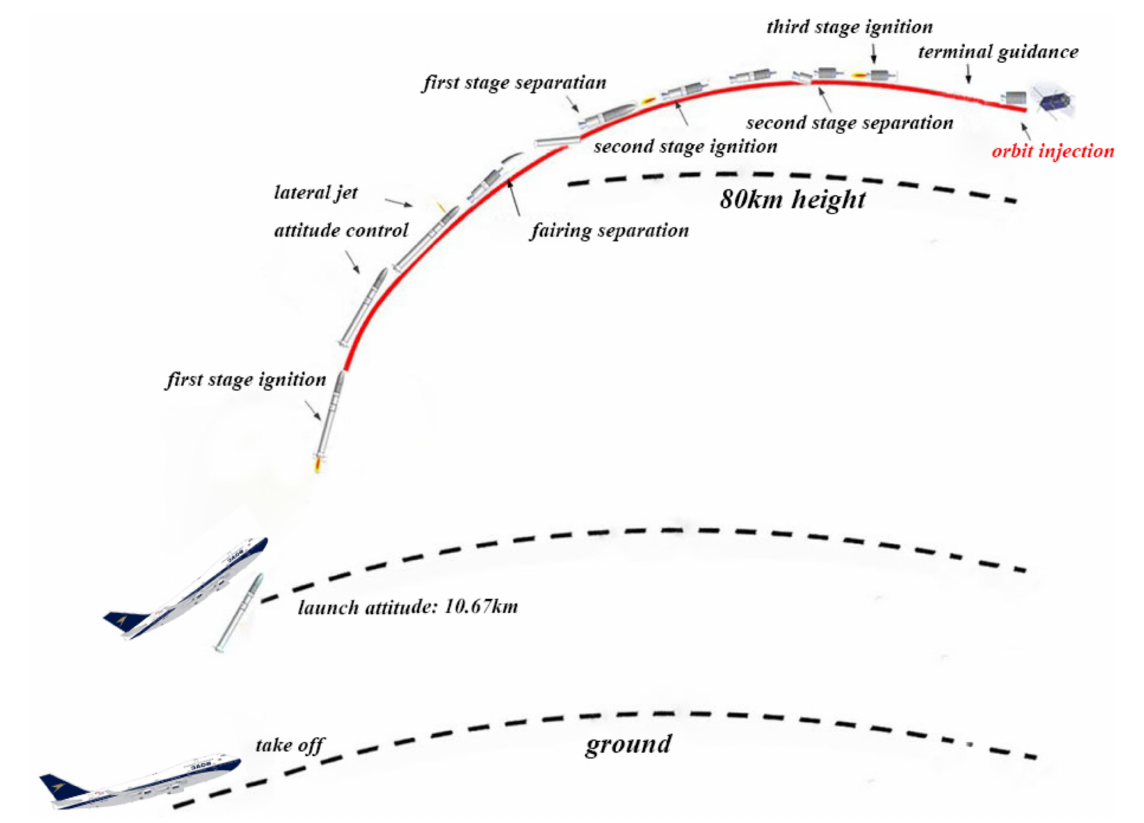
Figure 2. The flight process of a three-stage launch